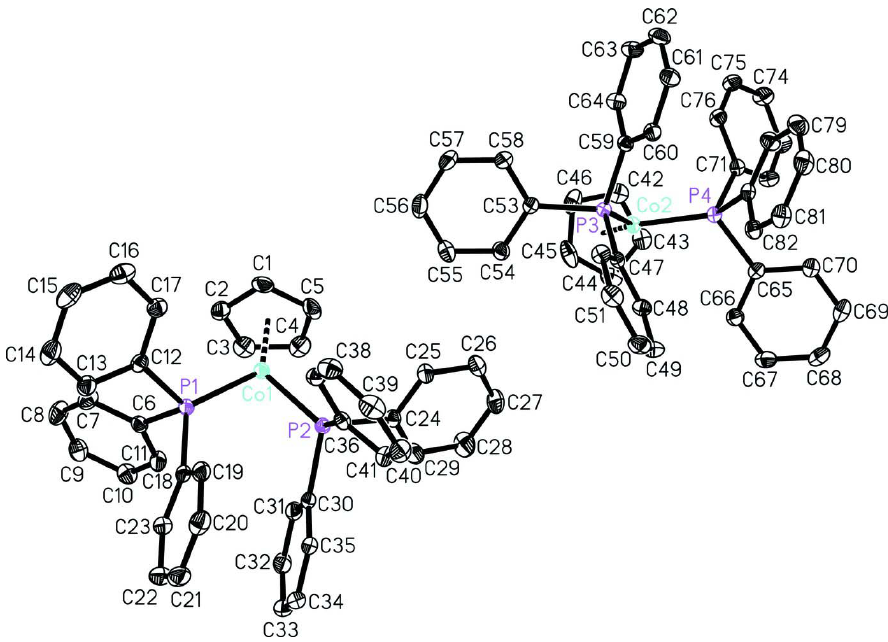
The molecular structure of the title compound showing the atom-labelling scheme (except C37, C52, C72, C73, C77 and C78). Thermal ellipsoids are drawn at the 30% probability level. Hydrogen atoms and solvent molecules are omitted for